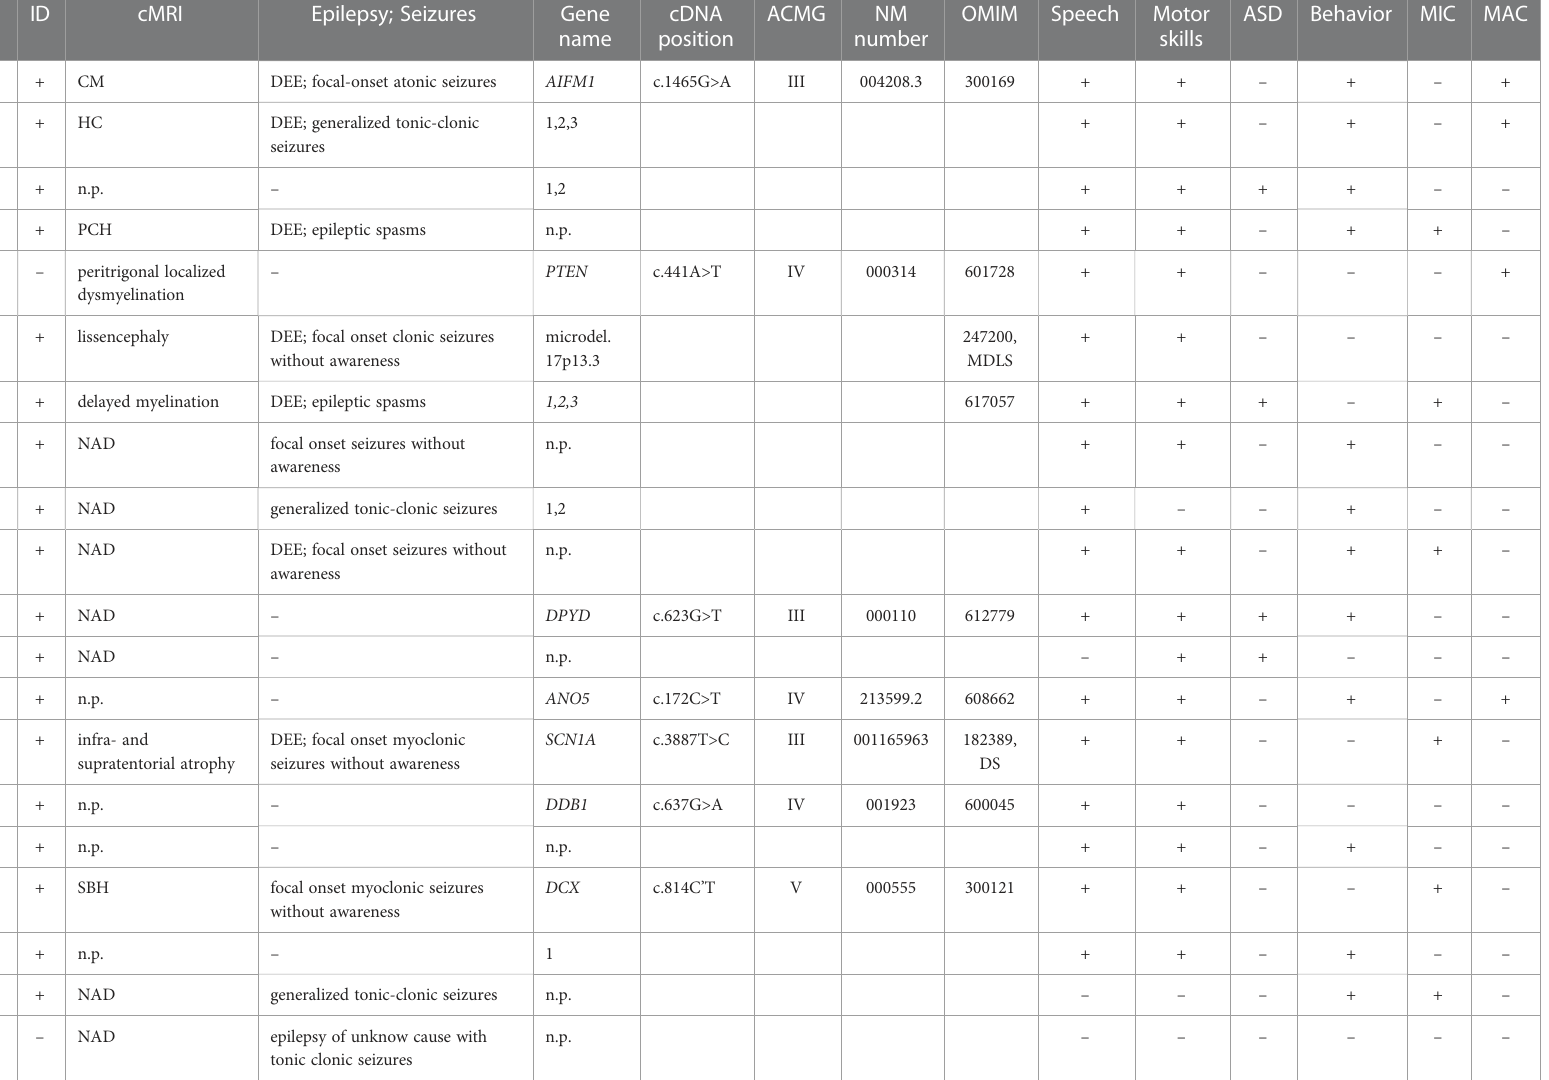
TABLE 1 Phenotype of patients with positive maternal synapsin I (SYN1) autoantibodies.